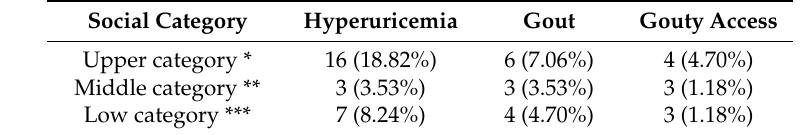
Table 4. Hyperuricemia, gout and gouty access by social category. Social Category Hyperuricemia Gout Gouty Access Upper category